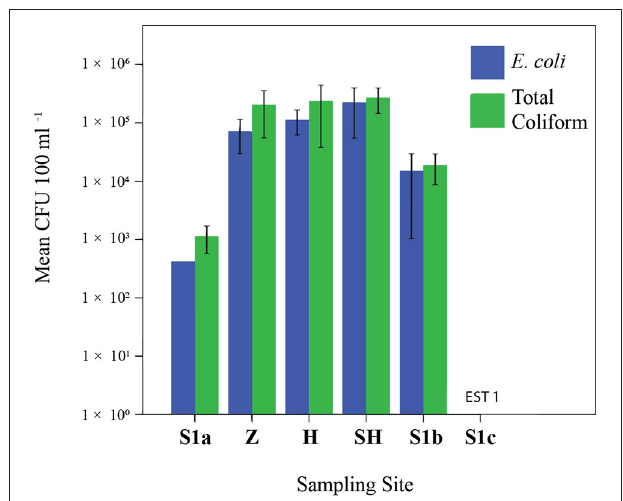
FIGURE 2 | Abundance of Escherichia coli and total coliform. EST, estimation. Sampling sites: Z, Zoo; H, Hospital; SH,